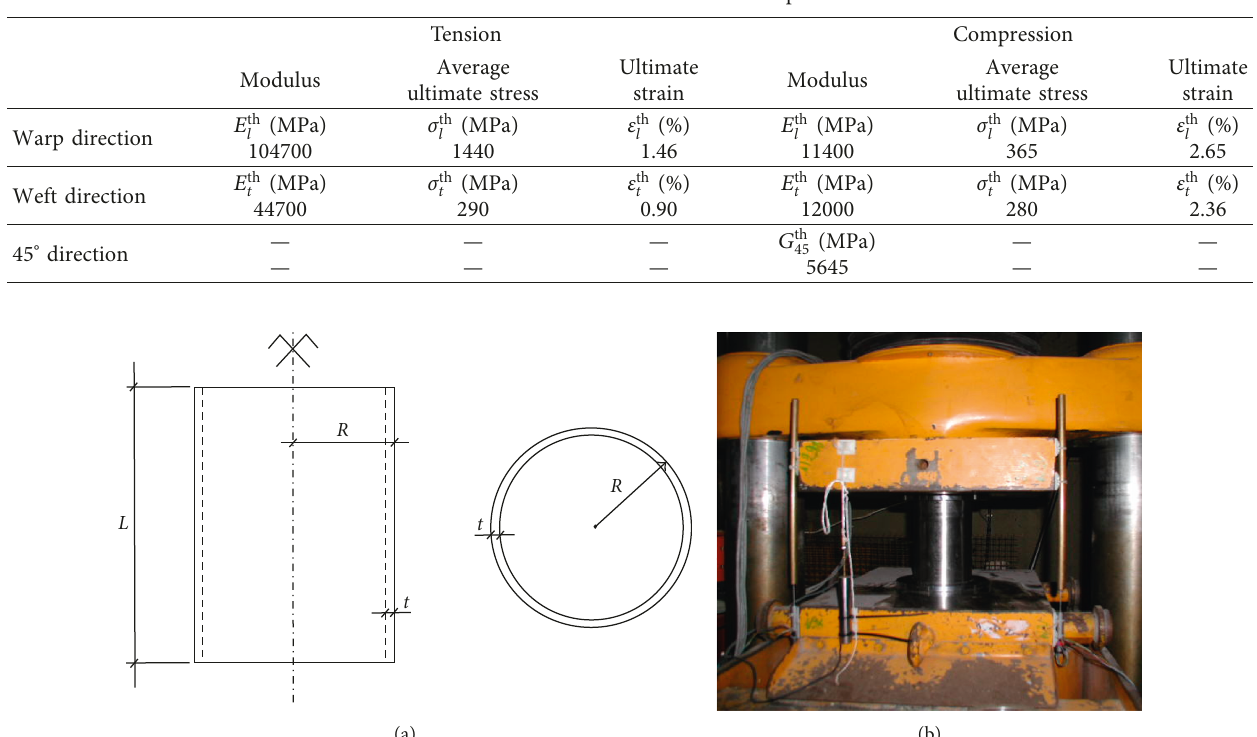
Table 1: Characterization of CFRP composite.